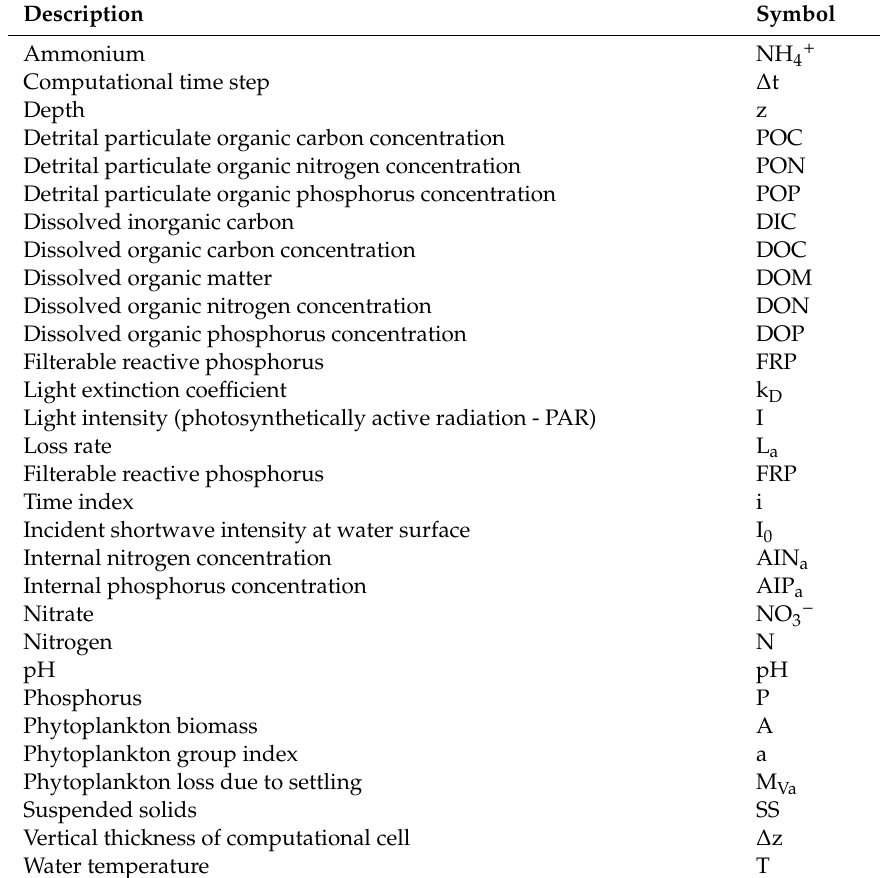
Table A4. Description of CAEDYM variables for phytoplankton modelling. a is related to phytoplankton group.